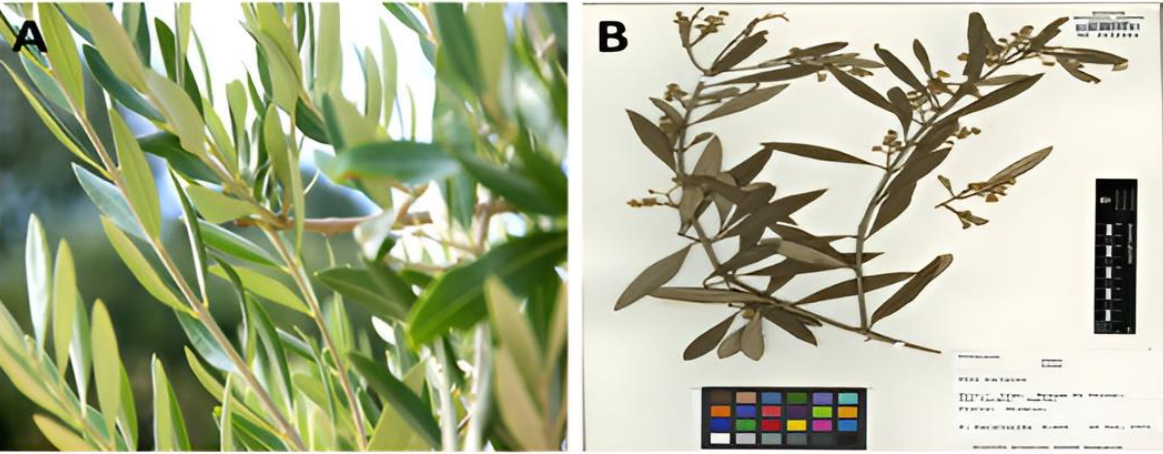
Figure 1. ( A ) Olea europaea L. folium (Oleaceae) leaves; ( B ) Botanical Voucher Specimen, MOBOT, Tropicos.org (http://www.tropicos.org/Image/100000992, accessed on: 1 April 2022).